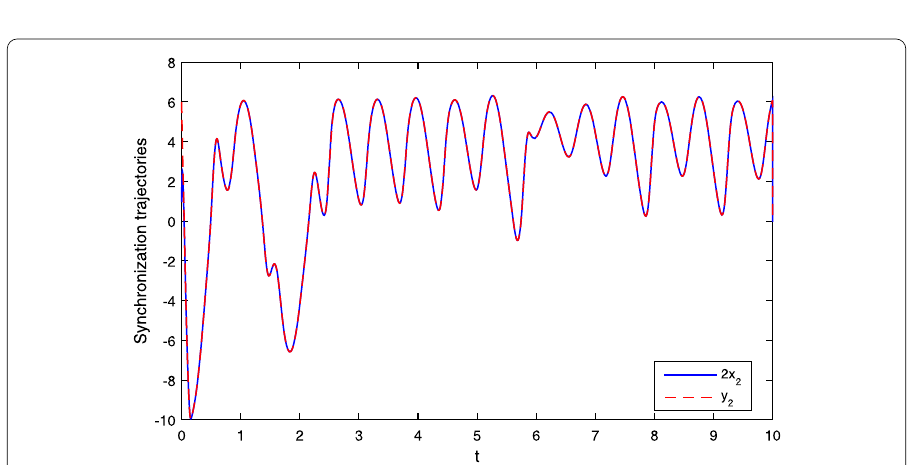
Figure 4 The synchronization trajectories of x 2 , y 2 with β =